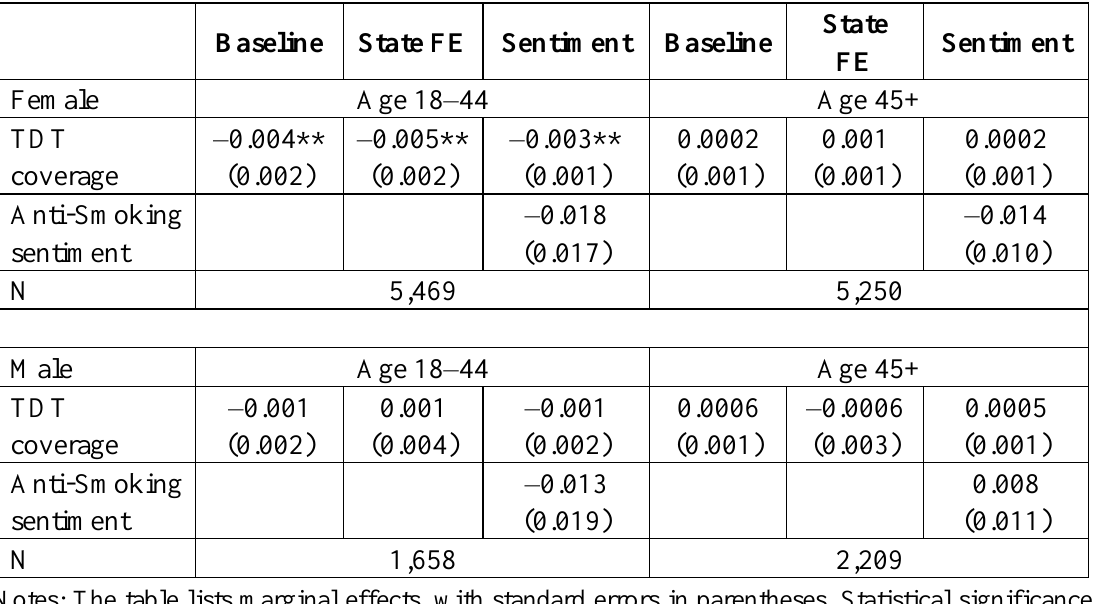
Table 5. Probit model of smoking